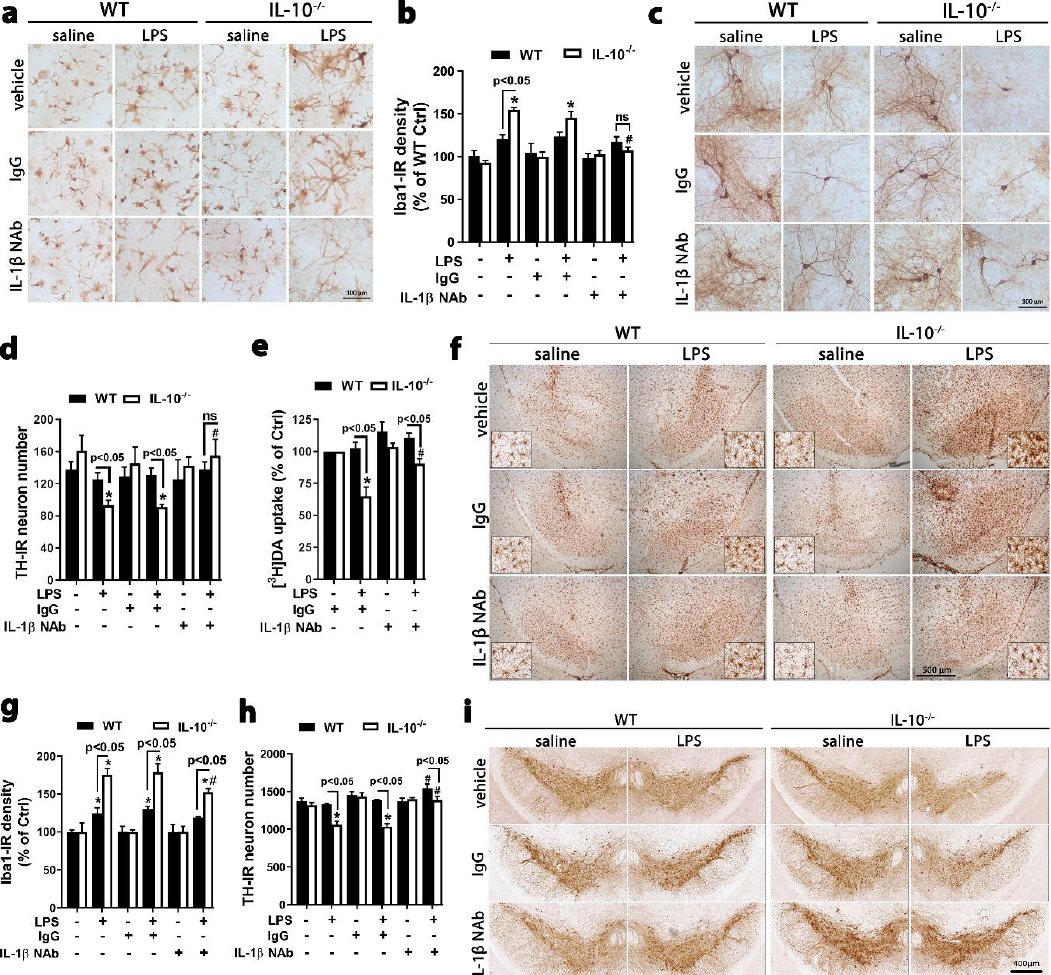
Figure 6. Neutralization of IL-1 β attenuated microglial activation and dopaminergic neurodegeneration in IL-10 − / − mice and midbrain neuron-glia cultures. ( a – e ) Immunohistochemistry images, densitometry analysis, cell count, and [ 3 H]DA uptake assay showing microglial activation ( a , b ) and loss of TH-IR DA neurons ( c – e ) 7 d after LPS treatment in midbrain neuron-glia cultures generated from IL-10 − / − mice. Post treatment with an 18 h delay with 1 µ g / mL IL-1 β Nab, but not control IgG, blocked microglial activation ( a , b ) and dopaminergic neurodegeneration ( c – e ). ( f , g ) Immunohistochemistry images and densitometry analysis showing more profound microglial activation in the SN, as indicated by enlarged cell size and irregular cell shape ( f ) and Iba-1 upregulation ( f , g ) in IL-10 − / − mice than WT mice one month after an intranigral injection of 3 µ g LPS. Co-injection of 1 µ g IL-1 β NAb, but not control IgG, dampened LPS-elicited microglial activation. In the SN injected with saline and IgG or saline and NAb, microglia exhibited the ramified resting morphology and only displayed activated morphology in the very limited area along the needle tracks. ( h , i ) Cell count and immunohistochemistry images showing significant reduction in the number of nigral TH-IR DA neurons in IL-10 − / − mice, but not in WT mice, one month after intranigral LPS injection. IL-1 β NAb, but not control IgG, reversed such neuronal loss in IL-10 − / − mice. Results are the mean ± SEM. Significance was determined by two-way ANOVA with Tukey’s multiple comparisons for b ( n = 3), e ( n = 5), g ( n = 4), and h ( n = 3 to 6) and student t-test for d ( n = 4). * p < 0.05 as compared with the corresponding saline-treated control cultures or saline-injected control mice and # p < 0.05 as compared with the corresponding LPS-treated cultures or LPS-injected mice. Immunostaining images were representative of three ( a ), four ( c,f ), and three to six ( i ) independent experiments. ns, not significant.